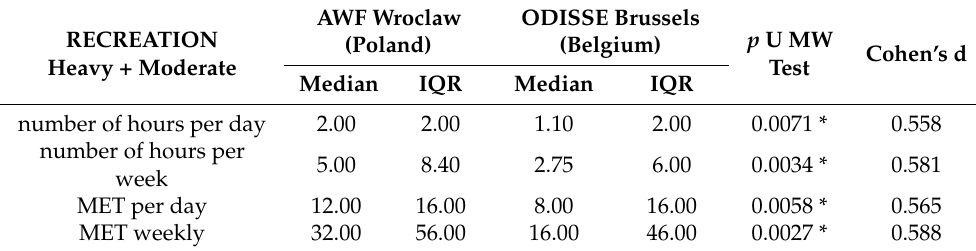
Table 8. Physical activity related to recreation activity (GPAQ). RECREATION